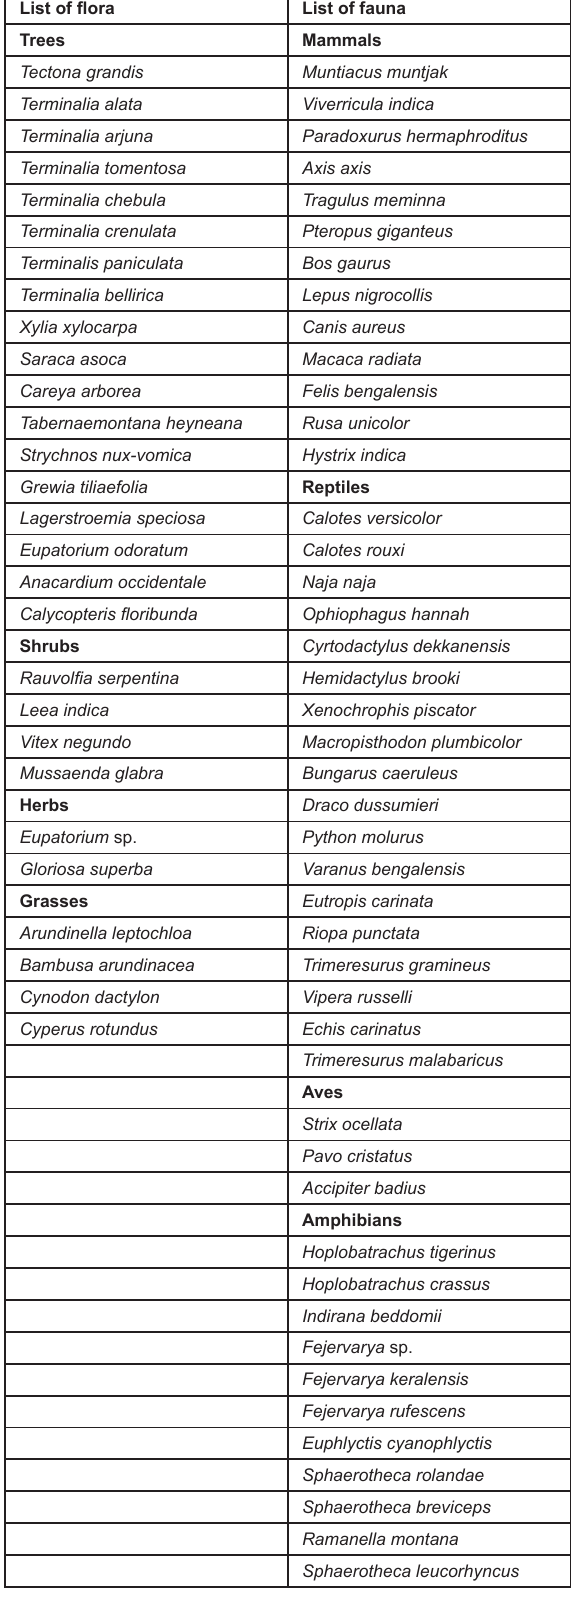
Table 1. List of floral and faunal associates of H. hypnale .